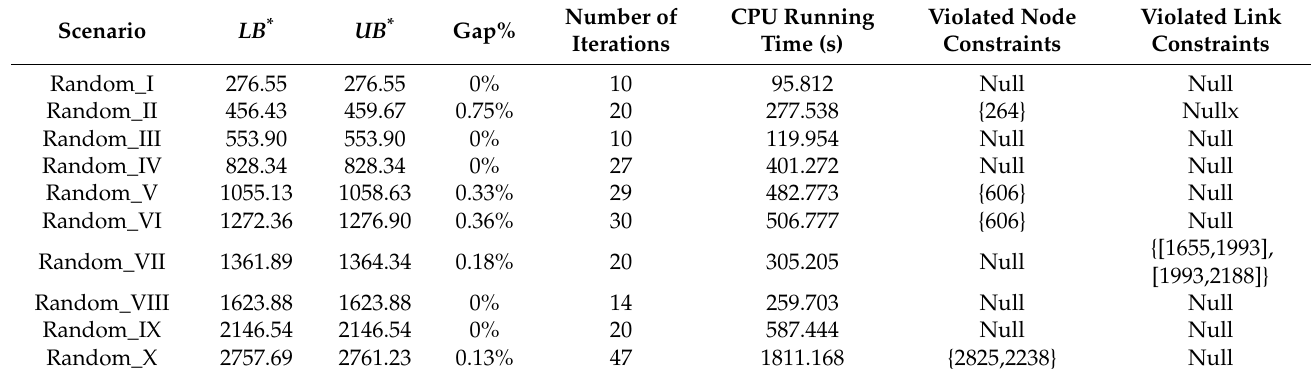
Table 11. Experimental results of random